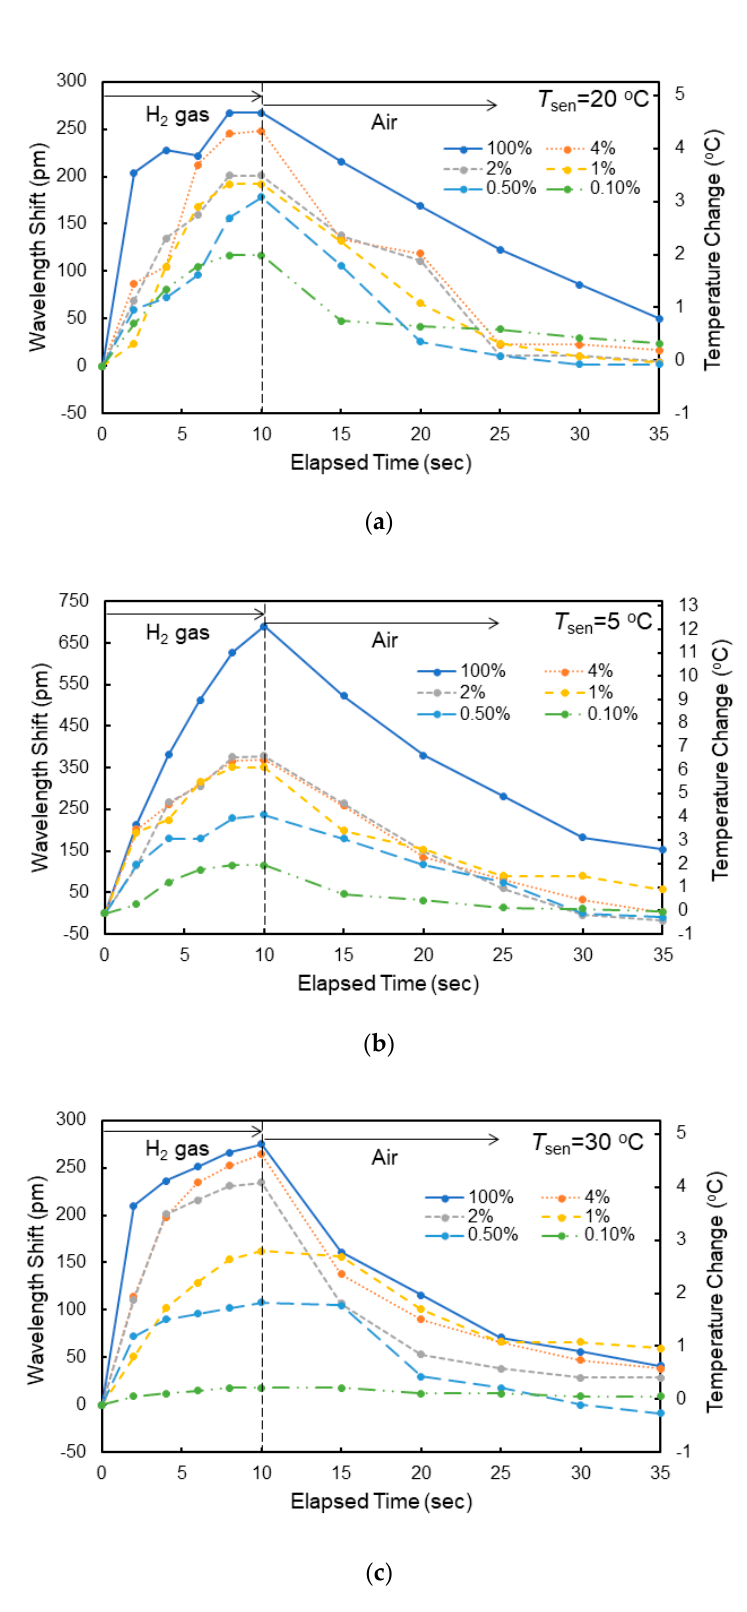
Figure 9. Resonant wavelength shift of MRR sensor when exposed to hydrogen/air mixed gases with different hydrogen concentrations measured at ( a ) 20 °C, ( b ) 5 °C, and ( c ) 30 °C.